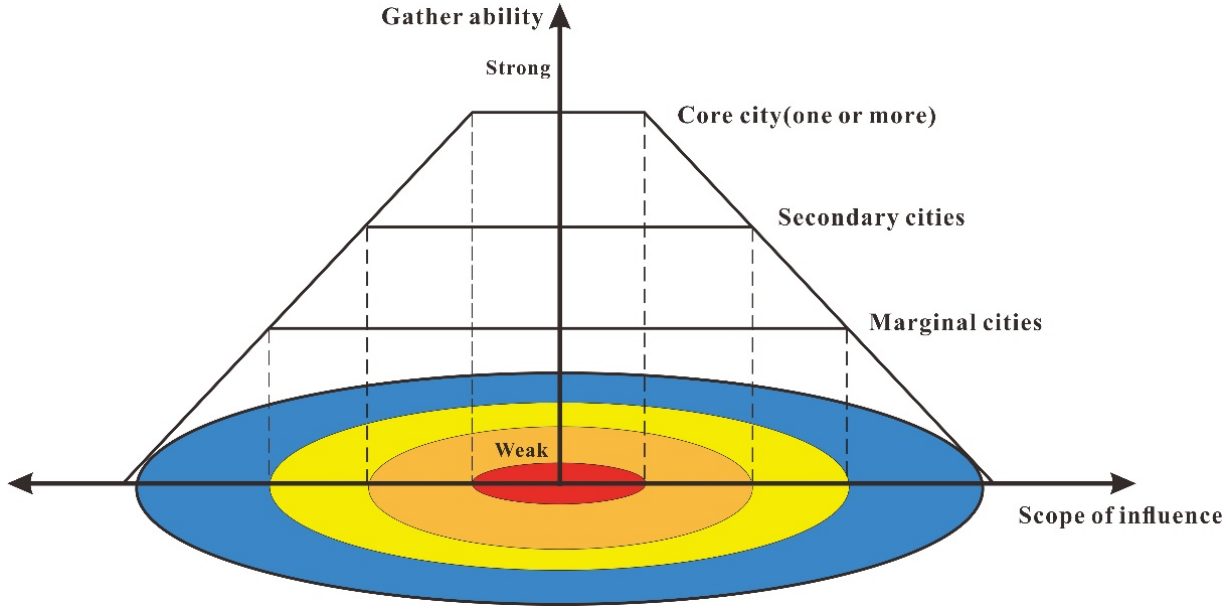
Figure 1. A conceptual map of metropolitan areas’ spatial structure.